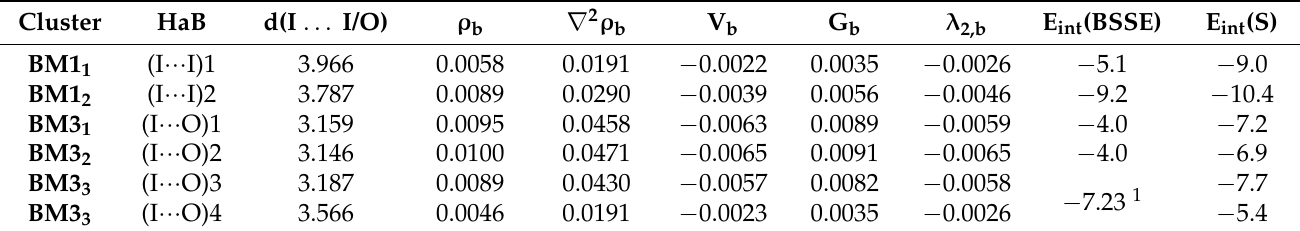
Figure 6. Contour line diagram of the Laplacian distribution ∇ 2 ρ (r), selected bond paths, zero flux surfaces ( A , C , E ) and the sign( λ 2 ) ρ (r) function mapped on the δ g inter isosurface of 0.005 a.u. and blue-cyan-green-yellow-red color scale − 0.02 < sign( λ 2 ) ρ (r) < 0.02 for the I ··· I and I ··· O contacts ( B , D , F ) for BM1 1 ( A , B ), BM1 2 ( C , D ) and BM3 1 ( E , F ). Table 4. Halogen bond lengths, d (in Å), calculated electron density, ρ b , its Laplacian, ∇ 2 ρ b , potential and kinetic energy densities, V b and G b , second eigenvalue of the hessian matrix, λ 2,b , at BCPs (in a.u.) and interaction energies, E int (in